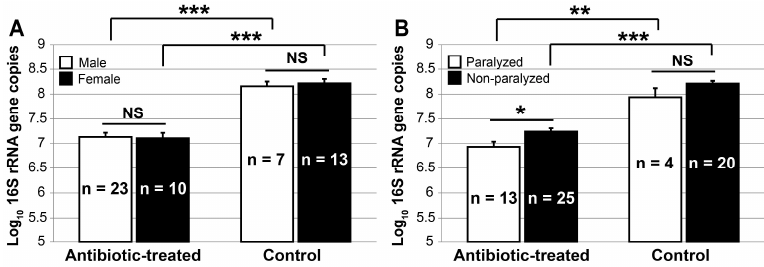
Figure 3. The estimated mean (± SE) log 10 Burkholderia 16S rRNA gene copies per insect in the midgut crypts of Blissus insularis fifth instars, from the antibiotic-treated and control groups. ( A ) Mean (±SE) log 10 Burkholderia 16S rRNA gene copies in the male and the female fifth instars; ( B ) Mean (±SE) log 10 Burkholderia 16S rRNA gene copies in the paralyzed and the non-paralyzed fifth instars that were exposed to 0.1 μ g mL − 1 of bifenthrin. The number in each bar indicates the total number of B. insularis fifth instars within each treatment. NS, no significant difference ( α = 0.05); *, p < 0.05; **, p < 0.01; ***, p < 0.001. See tabulated data in Table S1.